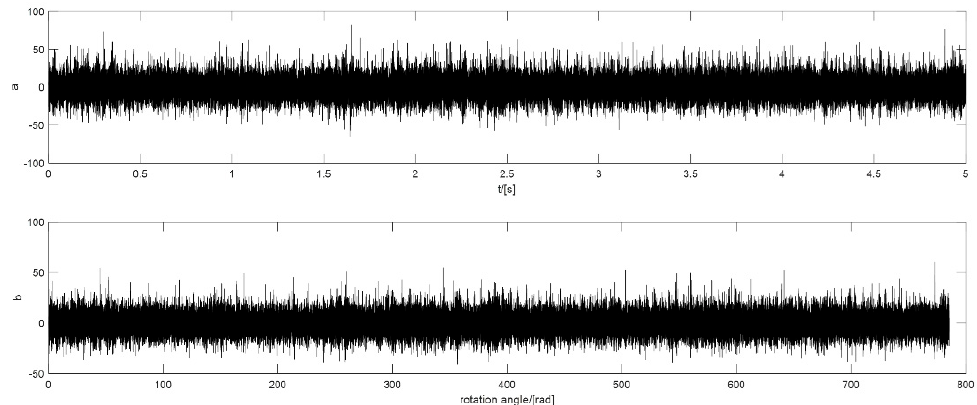
Figure 13. The vibration signal of roller defect with a constant speed: ( a ) the raw signal; ( b ) the signal after pre ‐ processing.